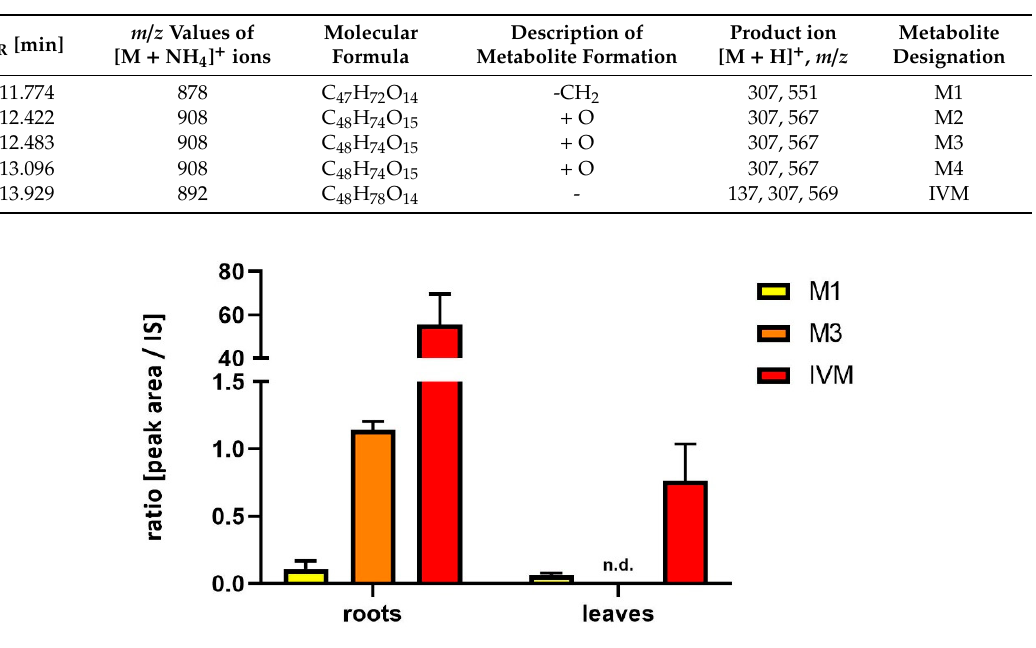
Table 1. Description of the metabolites of ivermectin (IVM) present in Glycine max detected by UHPLC-MS/MS.